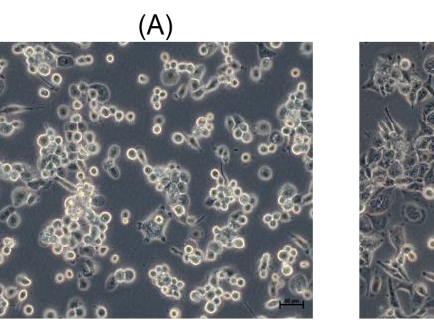
Figure 1. Differentiation of THP-1 monocytes into M1 and M2 macrophages. ( A ) THP-1 cells were induced to form M0 macrophages with the treatment of PMA (200 ng/mL) for 24 h. ( B ) M0 macro- phages were polarized into M1 macrophages using 100 ng/mL of LPS and 20 ng/mL of recombinant human IFN-γ. The sharpened shapes of M1 macrophages are indicated by arrow. ( C ) M0 macro- phages were polarized into M2 macrophages using 20 ng/mL of recombinant human IL-4 and 20 ng/mL of IL-13. The flattened shapes of M2 macrophages are indicated by arrow. Quantitative real time PCR analysis of M1 and M2 macrophage-specific gene expression was conducted. ( D ) TNF-α mRNA expression, ( E ) IL-1β mRNA expression, ( F ) IL-6 mRNA expression, ( G ) CD80 mRNA ex- pression, ( H ) IL-10 mRNA expression, and ( I ) CD206 mRNA expression. Details of the primers and qRT-PCR conditions are described in the Materials and Methods. Values are presented as the mean ± standard deviation relative to the control ( n = 3). * p < 0.05, ** p < 0.01. 2.2. Expression Profiles of P450s M1 macrophages were induced by IFN-γ/LPS treatment, resulting in the enhanced expression of IL-1β, IL-6, CD80 and tumor necrosis factor alpha (TNF-α). Meanwhile, M2 macrophages were induced by IL-13/IL-4 treatment and displayed upregulated levels of IL-10 and CD206 along with reduced expression of IL-1β, TNF-α, and IL-6. The expression of macrophage-specific CYP genes was investigated using RT-PCR with gene-specific pri- mers (Figure 2).